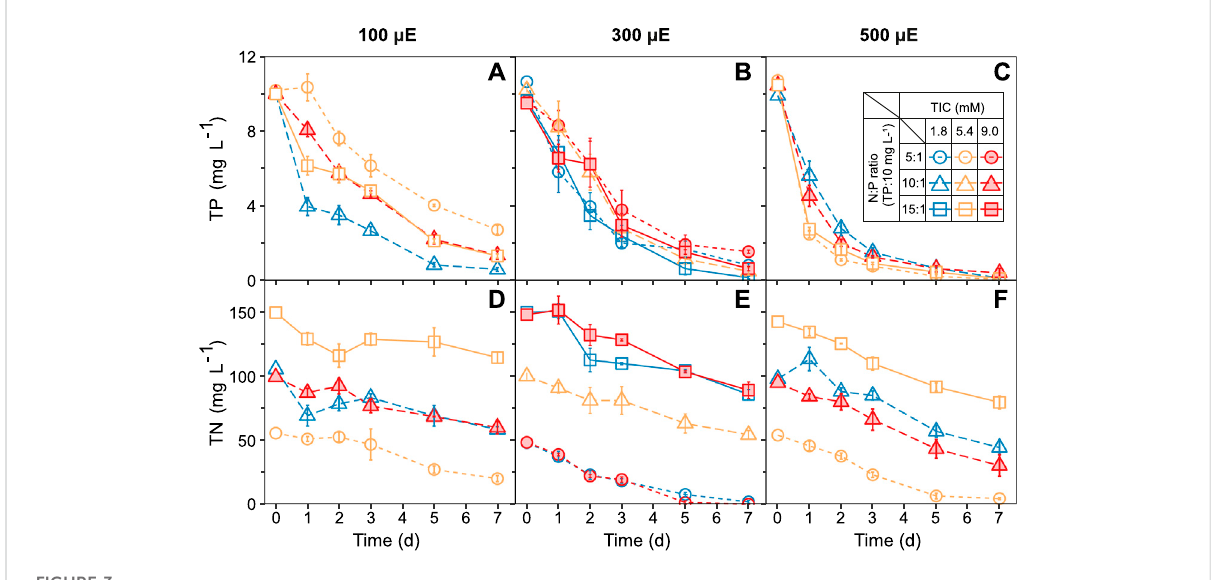
FIGURE 3 ATS-bio fi lmsshowedacontinuousnutrientremovalfromthemediumunderalltreatmentsover7days.Increasinglightintensitiesof (A,D) 100, (B,E) 300, and (C,F) 500 μ mol photons m − 2 s − 1 , respectively, increased the removal of phosphorus and nitrogen. Data are presented as mean ± standard error (SE, n = 3, except the treatment of central point: TIC = 5.4 mM, N:P ratio = 10:1, and light intensity = 300 μ mol, n = 9). TIC, total inorganic carbon; N:P, nitrogen-to-phosphorus ratio; TP, total phosphorus; TN, total nitrogen.